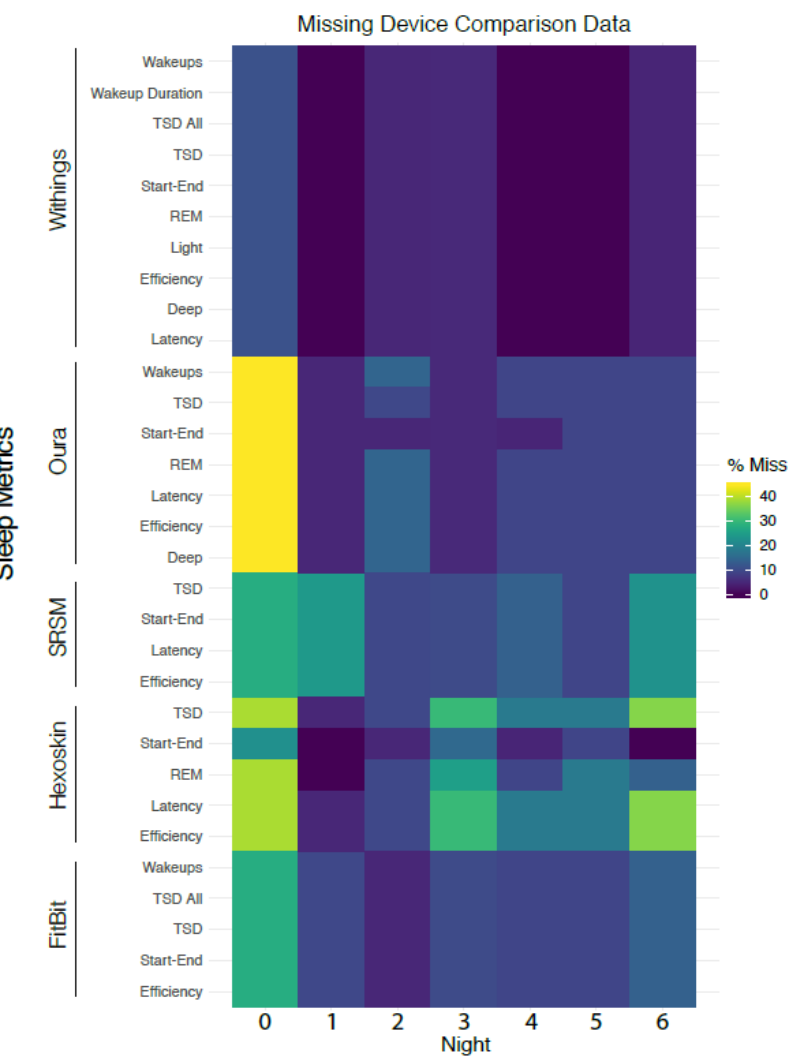
Figure 3. Plot of missing sleep-related data including SRSMs. Due to various device preferences, missing data are asymmetric across devices.